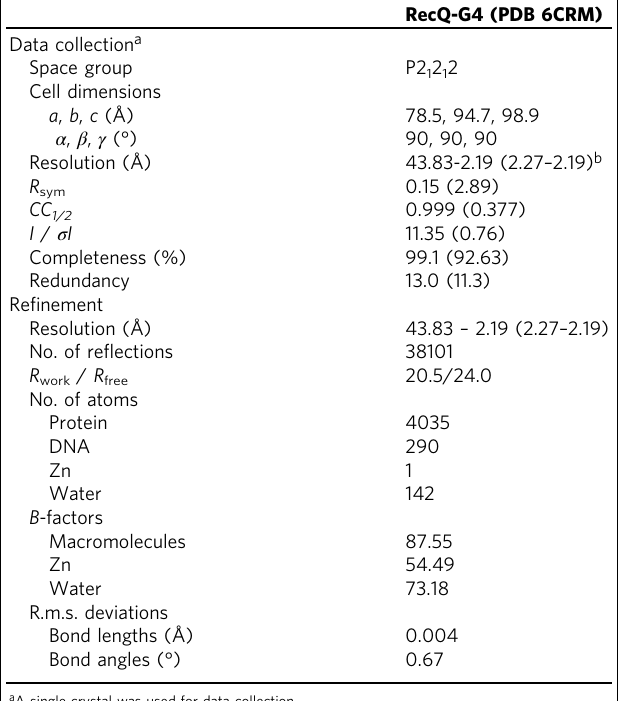
Table 1 Data collection and re fi nement statistics